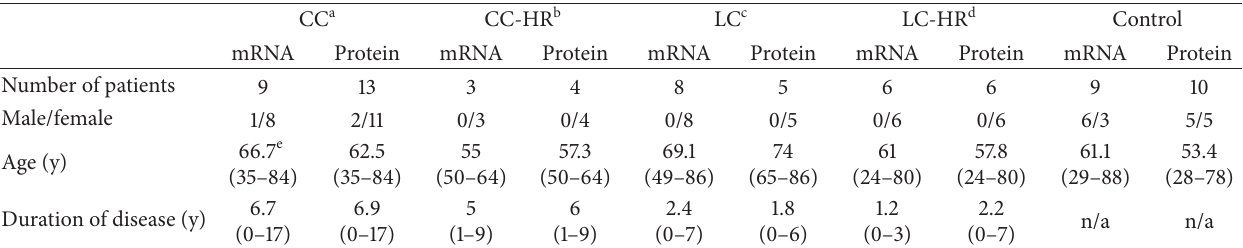
Table 1: Clinical characteristics of patients and